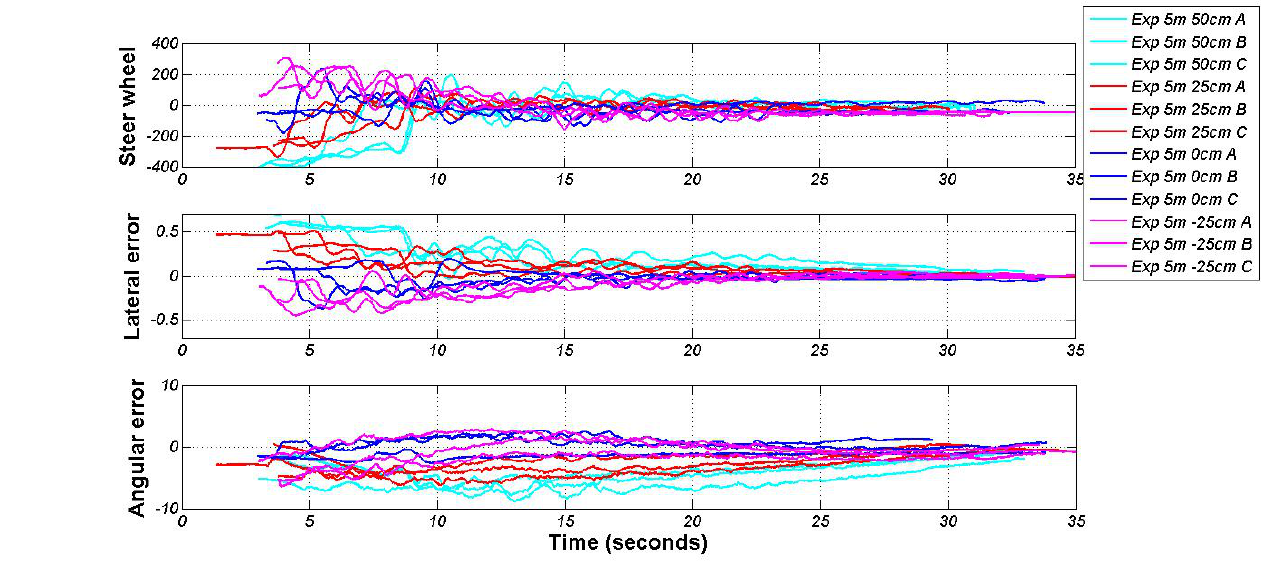
Figure 10. Validation tests: input variables and action lateral controller.